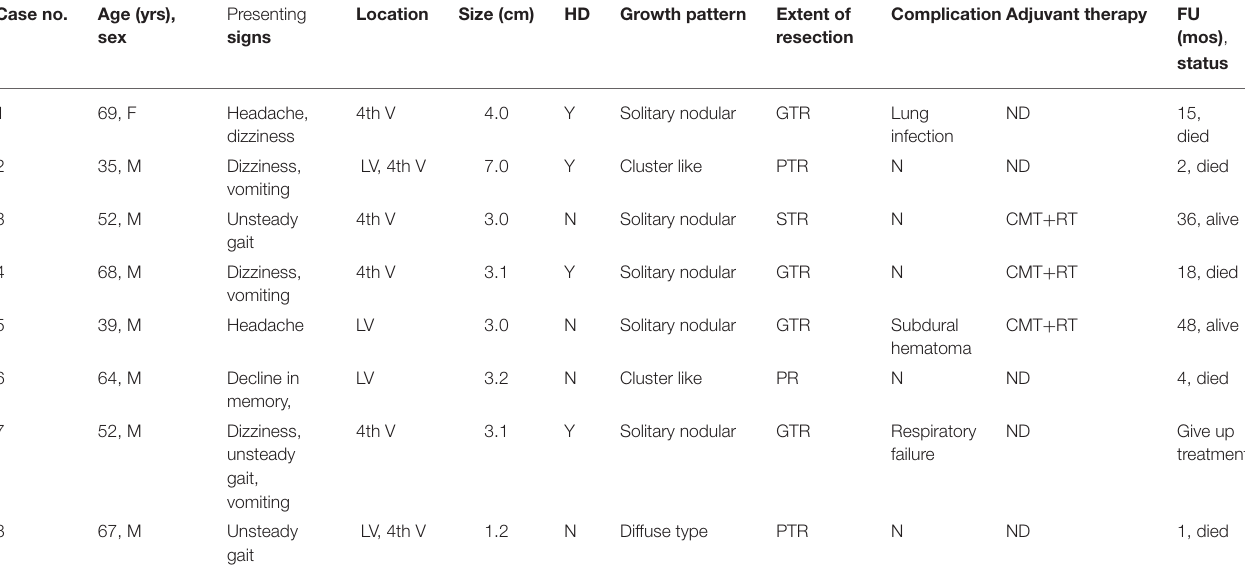
TABLE 1 | Characteristics of the 8 patients included in the series. Case no.